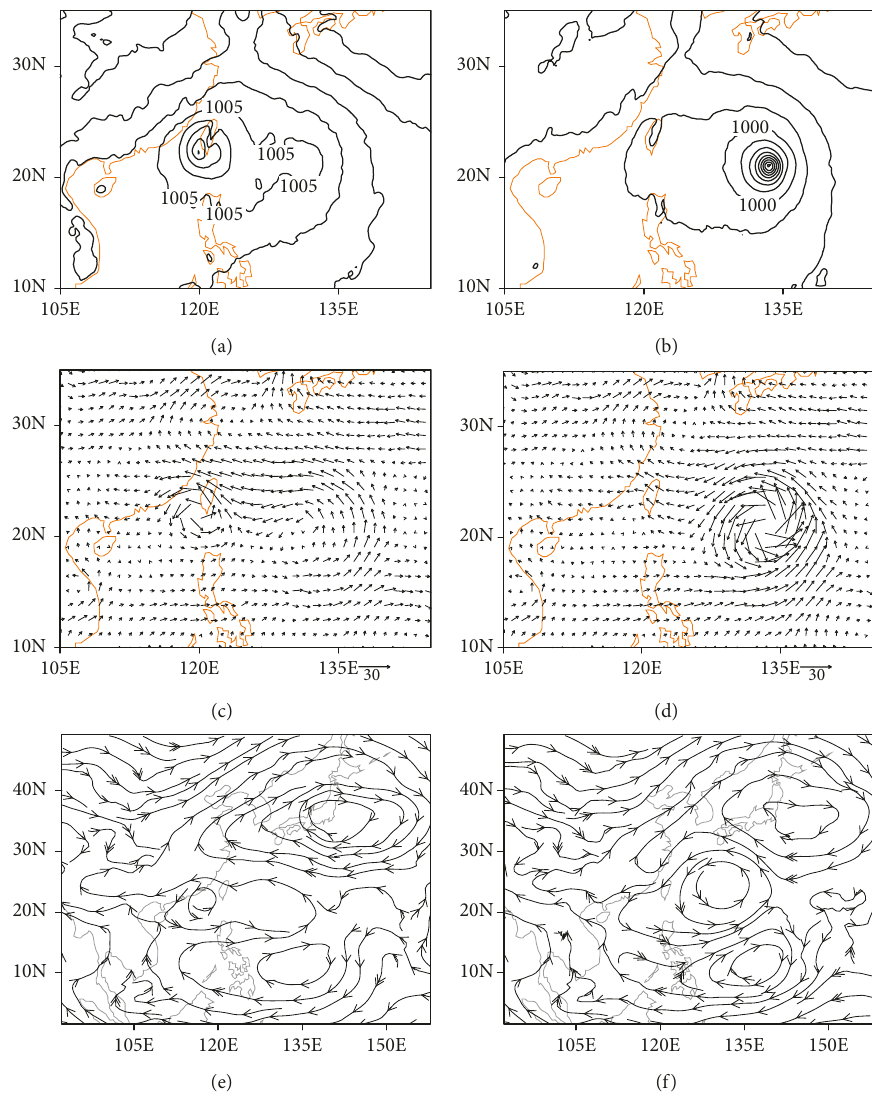
Figure 5: Sea-level pressure ((a, b), interval: 5hPa) and wind vector at 500 hPa (c, d) at 1200 UTC 24 August as well as streamline at 500 hPa at 0000 UTC 25 August (e, f) in the NoB (a, c, e) and NoT experiments (b, d, f),